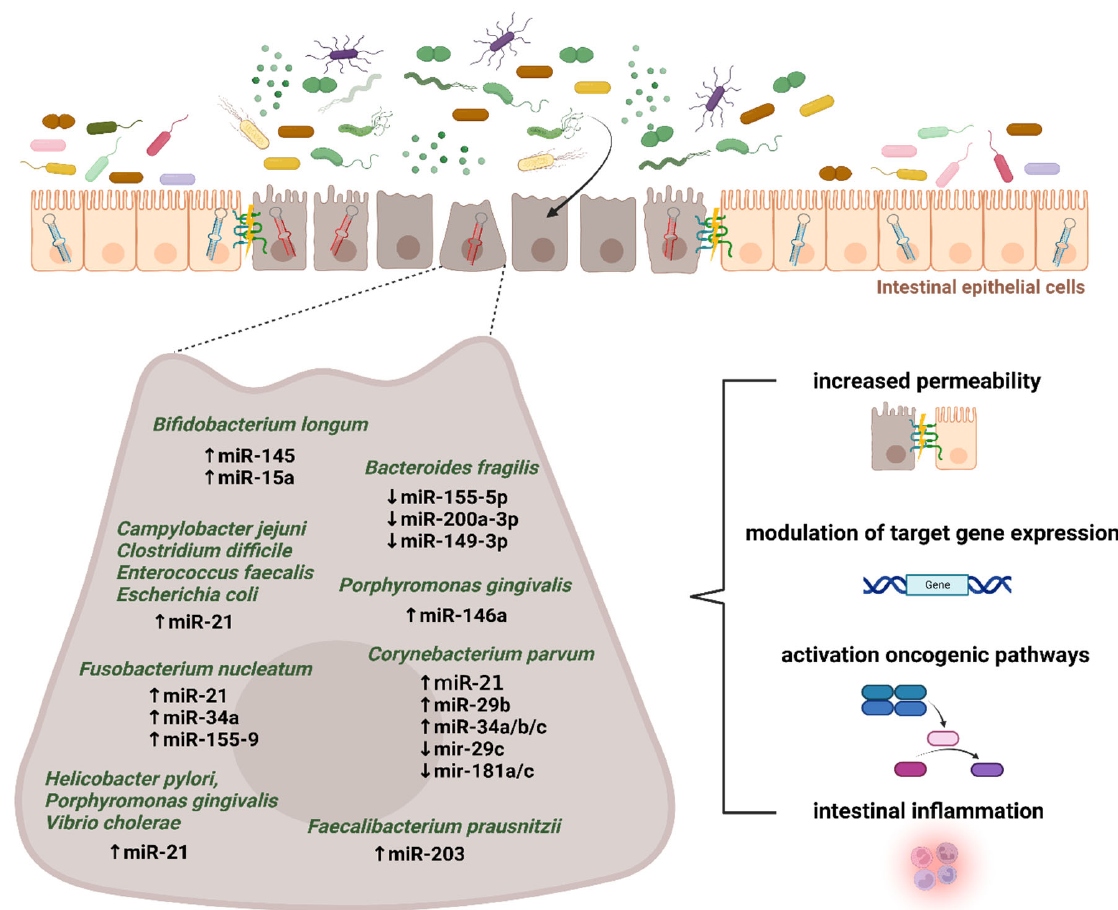
Figure 3. Microbiota–miRNA interactions in colorectal cancer development. Mounting evidence supports the existence of intensive host–microbiota crosstalk in maintaining gut barrier integrity and intestinal homeostasis. Several inflammation- and tumor-related microbial taxa were reported to play a significant role in modulating the microRNA expression in the intestinal epithelium. Subsequently, downstream targets and appropriate pathways might be involved in colorectal pathogenesis. The figure was created with BioRender.com (accessed on 16 November